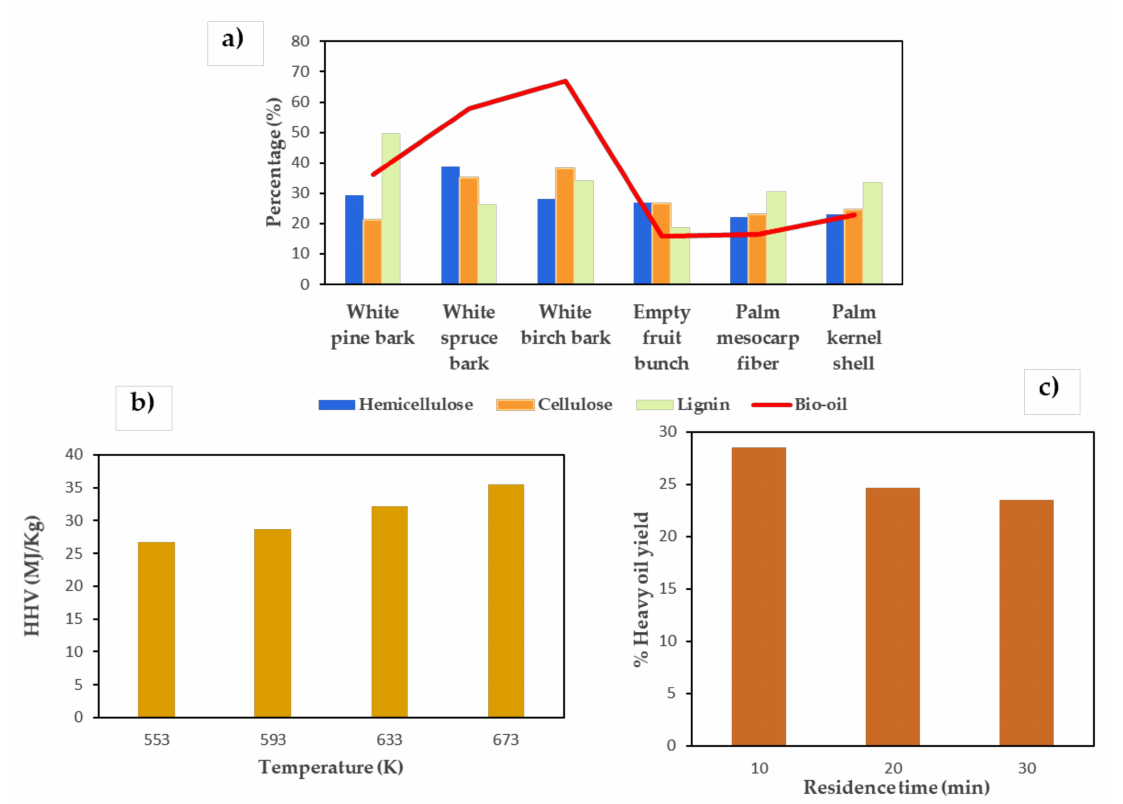
Figure 3. Effect of type of biomass ( a ) [99,100], temperature ( b ) [85,86] and residence time ( c ) [101] on HTL